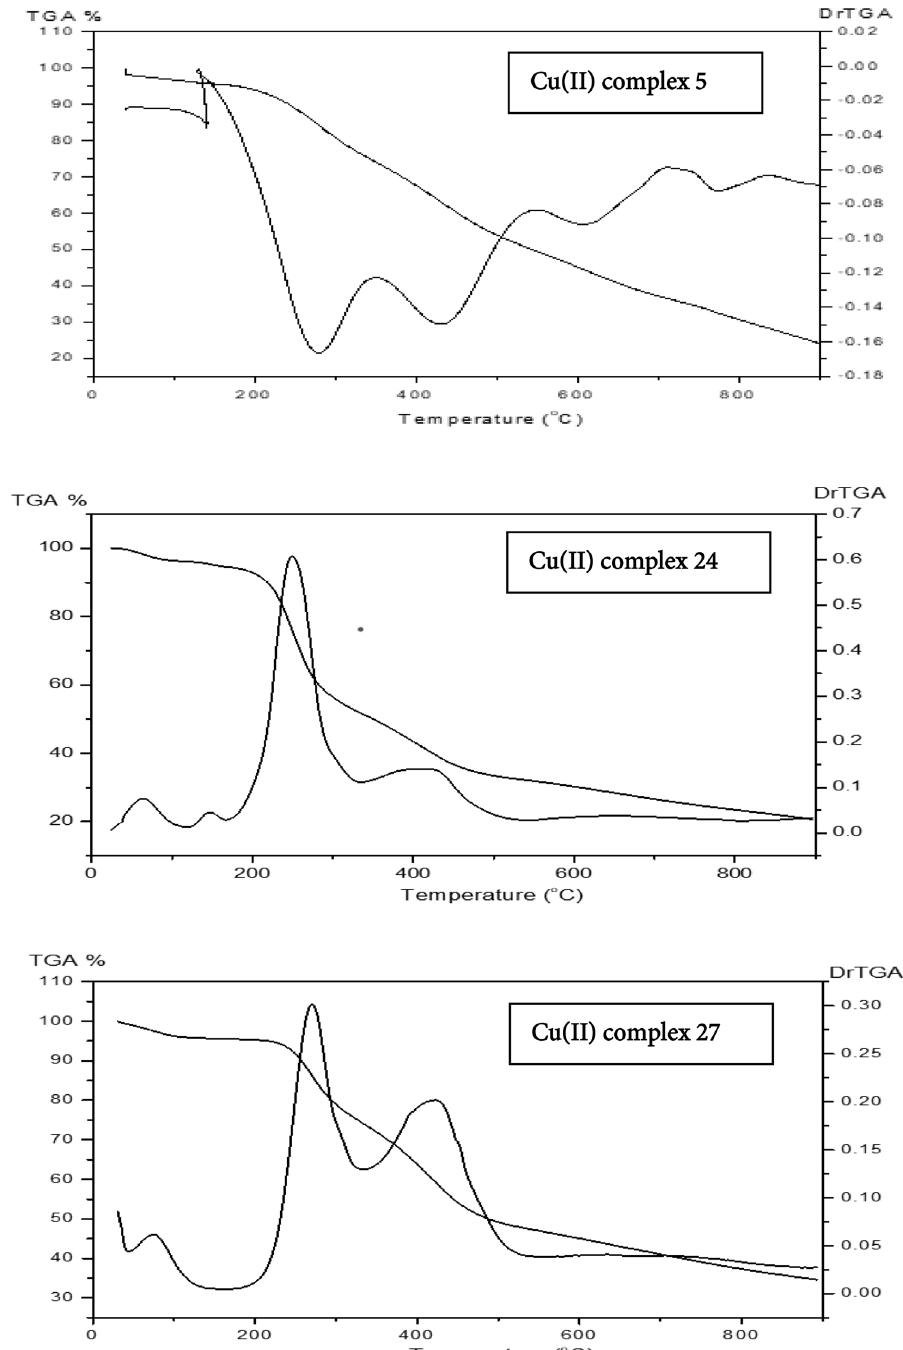
Figure 4. TGA–Dr TGA curves of the Cu(II) complexes 5, 24 and